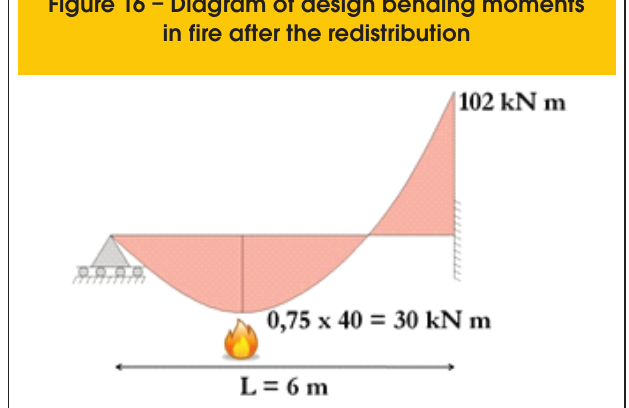
Figure 16 – Diagram of design bending moments in fire after the redistribution